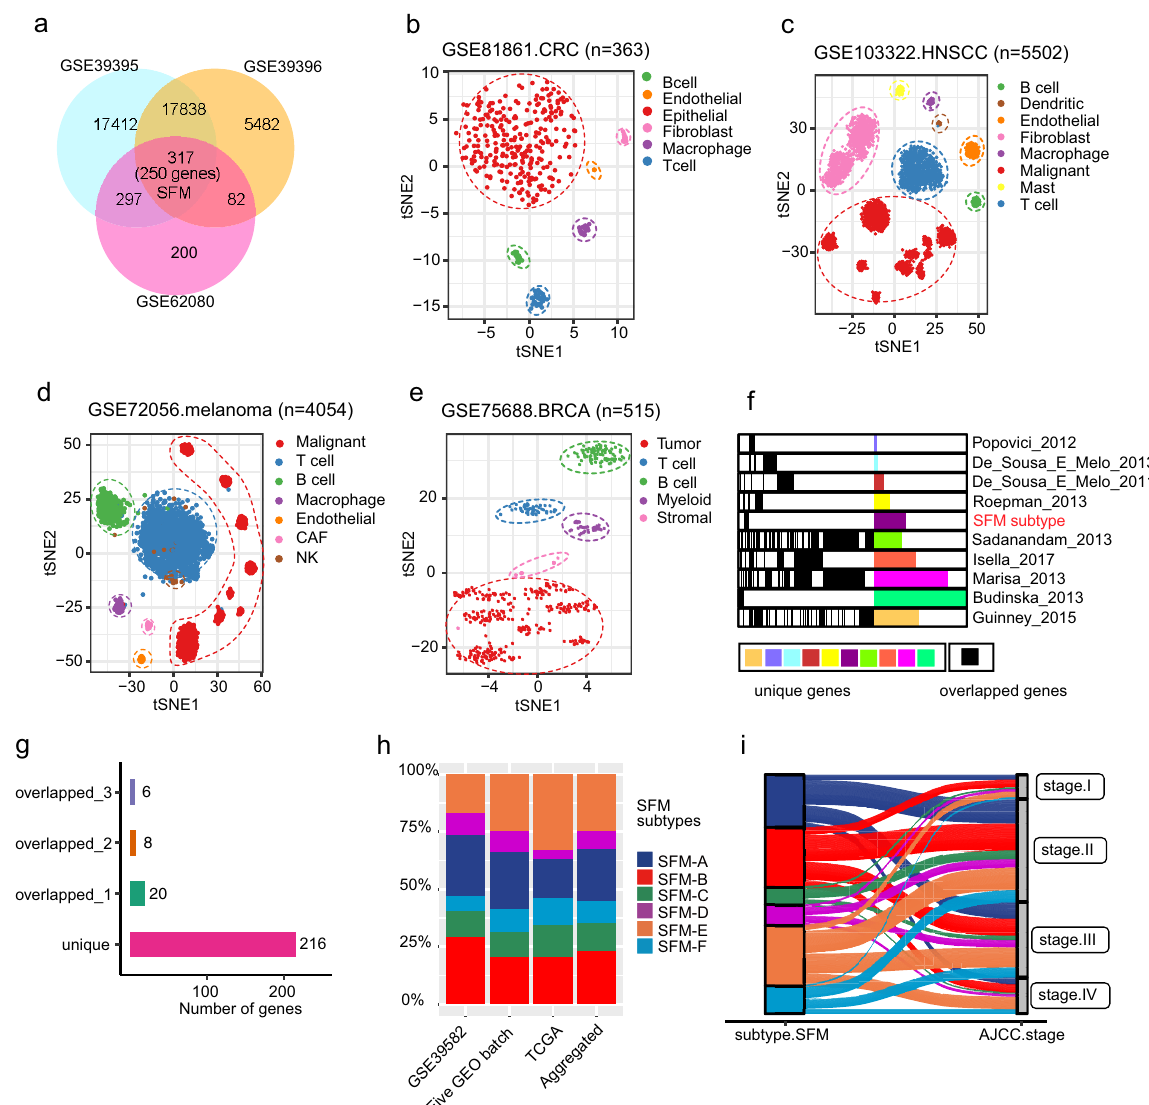
Fig. 1 Construction of SFM signature and subtypes. a Venn diagram of differentially expressed probe sets in three datasets showing intersection of 317 probes (250 unique genes). b – e t -SNE plot of SFM gene expression pro fi les from four datasets ( b , CRC, n = 363; c , HNSCC, n = 5502; d , melanoma, n = 4054; e , BRCA, n = 515). f – g Genes overlapped between SFM and published gene signatures. Each column indicates each gene signature and each row indicate each gene. Shared genes are indicated with black lines ( f ). Graph depicts the quanti fi cation of overlap across these signatures ( g ). h Proportion of SFM subtypes in individual and aggregated datasets. i Sankey diagram showing how each SFM subtype contributes to AJCC stage classi fi